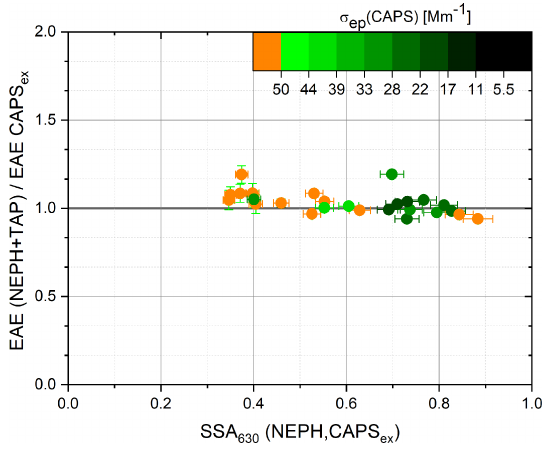
Figure 10. The extinction Ångström exponent EAE(NEPH, TAP)/EAE(CAPS) ratios as a function of 630nm wavelength SSA(NEPH, CAPS) values for AQ–AS mixtures. The 630nm wavelength light-absorption coefficient, σ ep (CAPS), is used as the colour code.